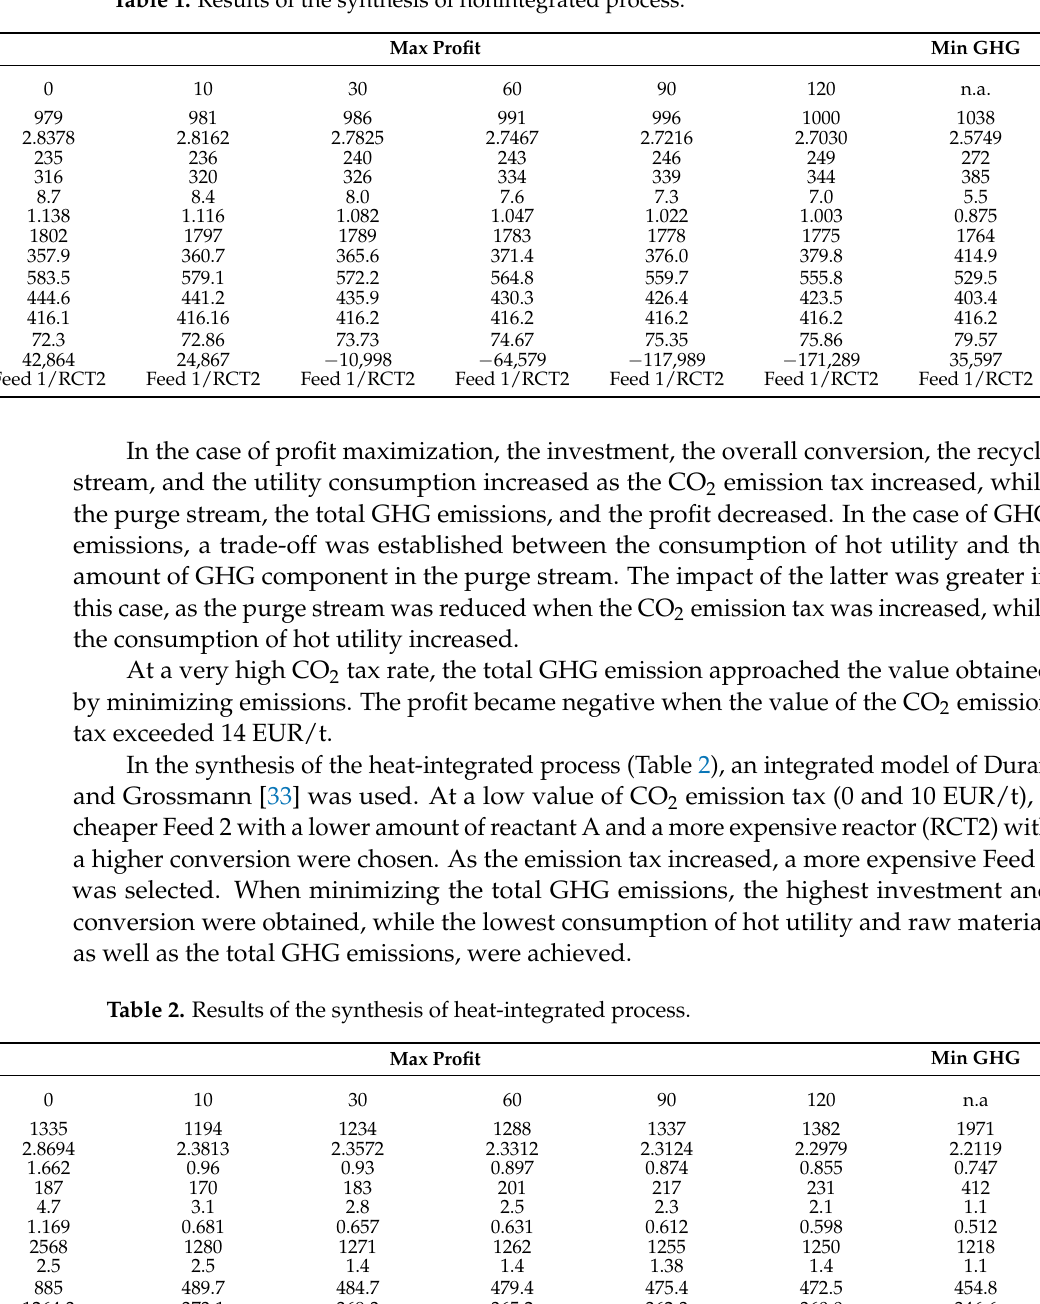
Table 1. Results of the synthesis of nonintegrated process.